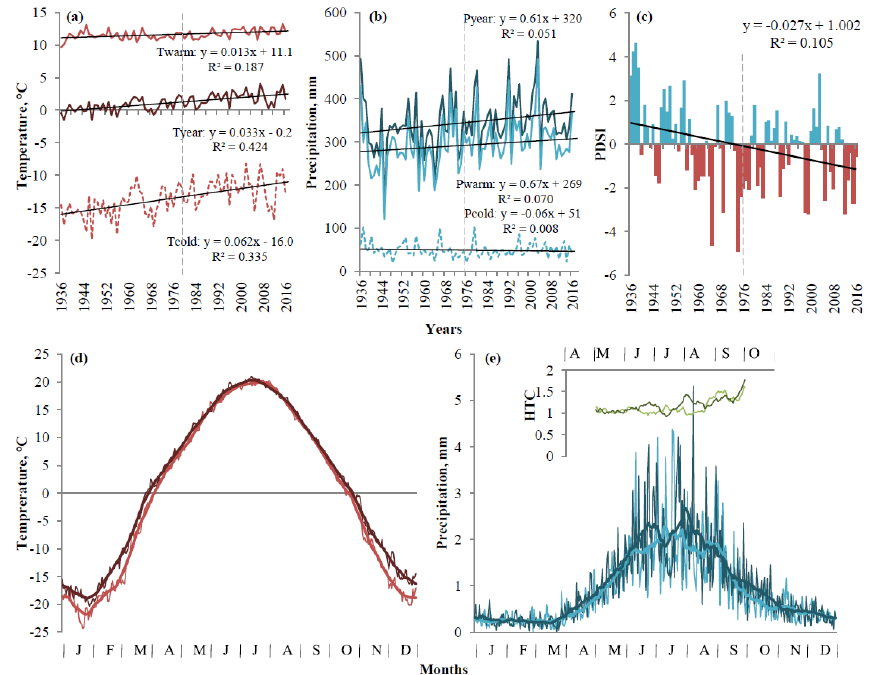
Figure 3. Climatic dynamics in the study area, as follows: ( a ) Inter-annual dynamics of the temperature integrated for the warm season (April–October), the cold season (November–March), and the calendar year straight lines represent the linear trends, vertical dashed lines divide the sub-periods. ( b ) The same plot for precipitation. ( c ) Inter-annual dynamics of the Palmer drought severity index (PDSI) in July; the line represents the linear trend, the vertical dashed line divides the sub-periods. ( d ) A comparison of the temperature of the intra-annual dynamics averaged over the 1936–1976 (light lines) and 1977–2017 (dark lines) sub-periods, thin lines represent the daily data, thick lines represent a 21-day moving average. ( e ) The same plot for precipitation, 21-day moving series of the hydrothermal coefficient (HTC) for the same sub-periods are shown as an inset plot.